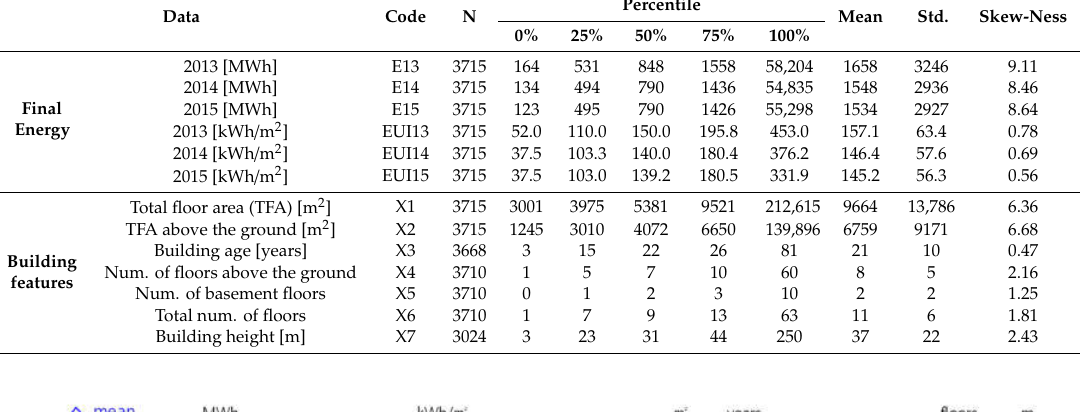
Table 2. Basic statistical analysis of collected office building data in Korea.